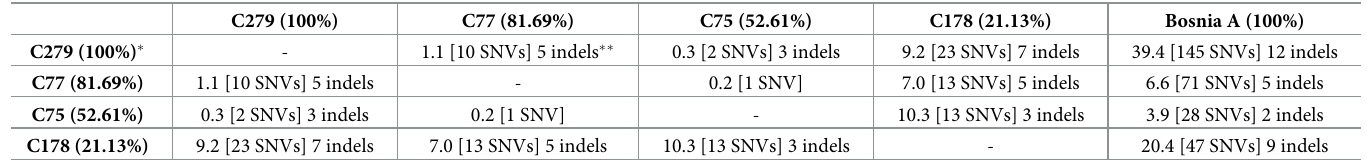
Breath of coverage of the corresponding whole genome sequence �� Indels were not used for nucleotide diversity calculations. #